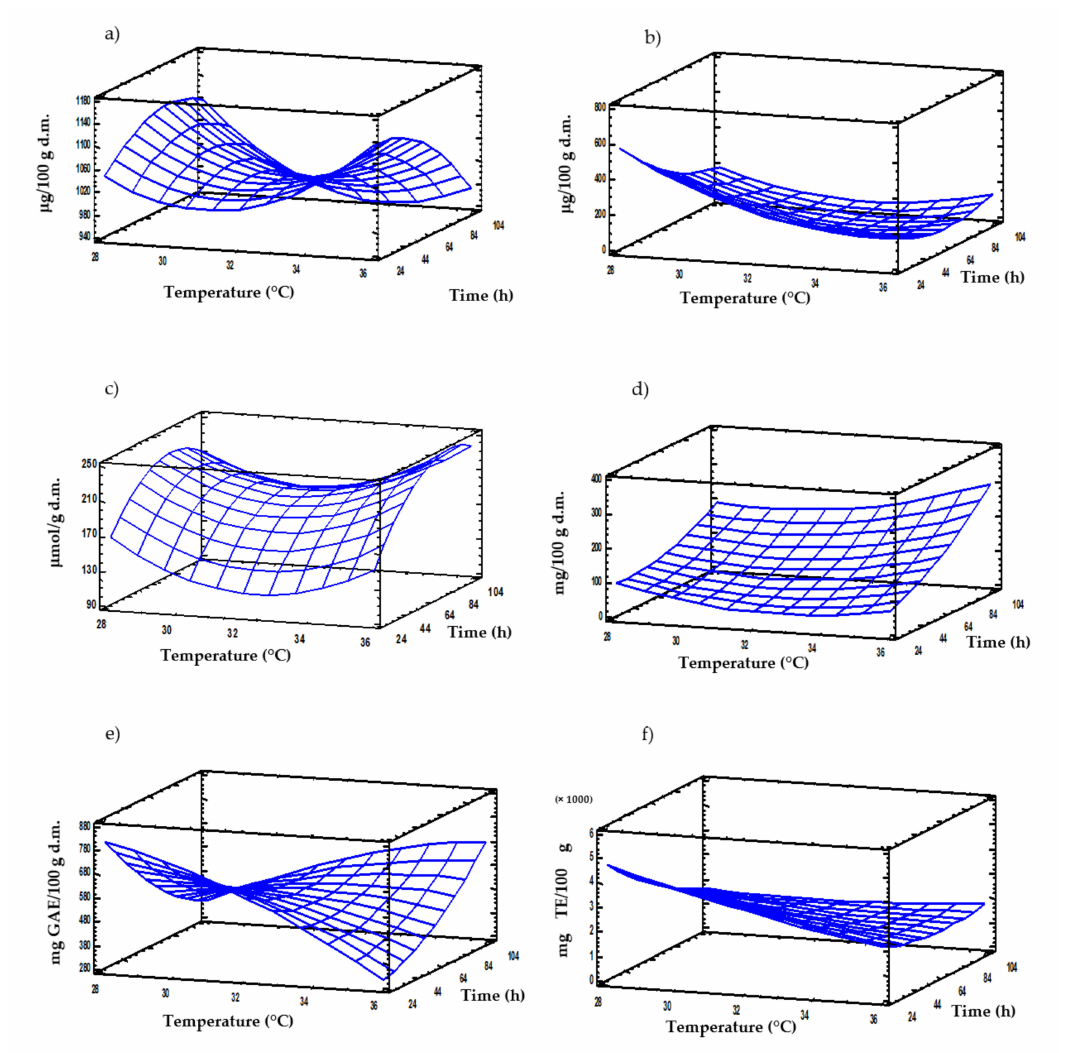
Figure 3. Response surface plots for contents of thiamine ( a ), riboflavin ( b ), glucosinolates ( c ), GABA ( d ), free phenolic compounds ( e ) and antioxidant activity ( f ) in sprouted moringa as a function of germination time and